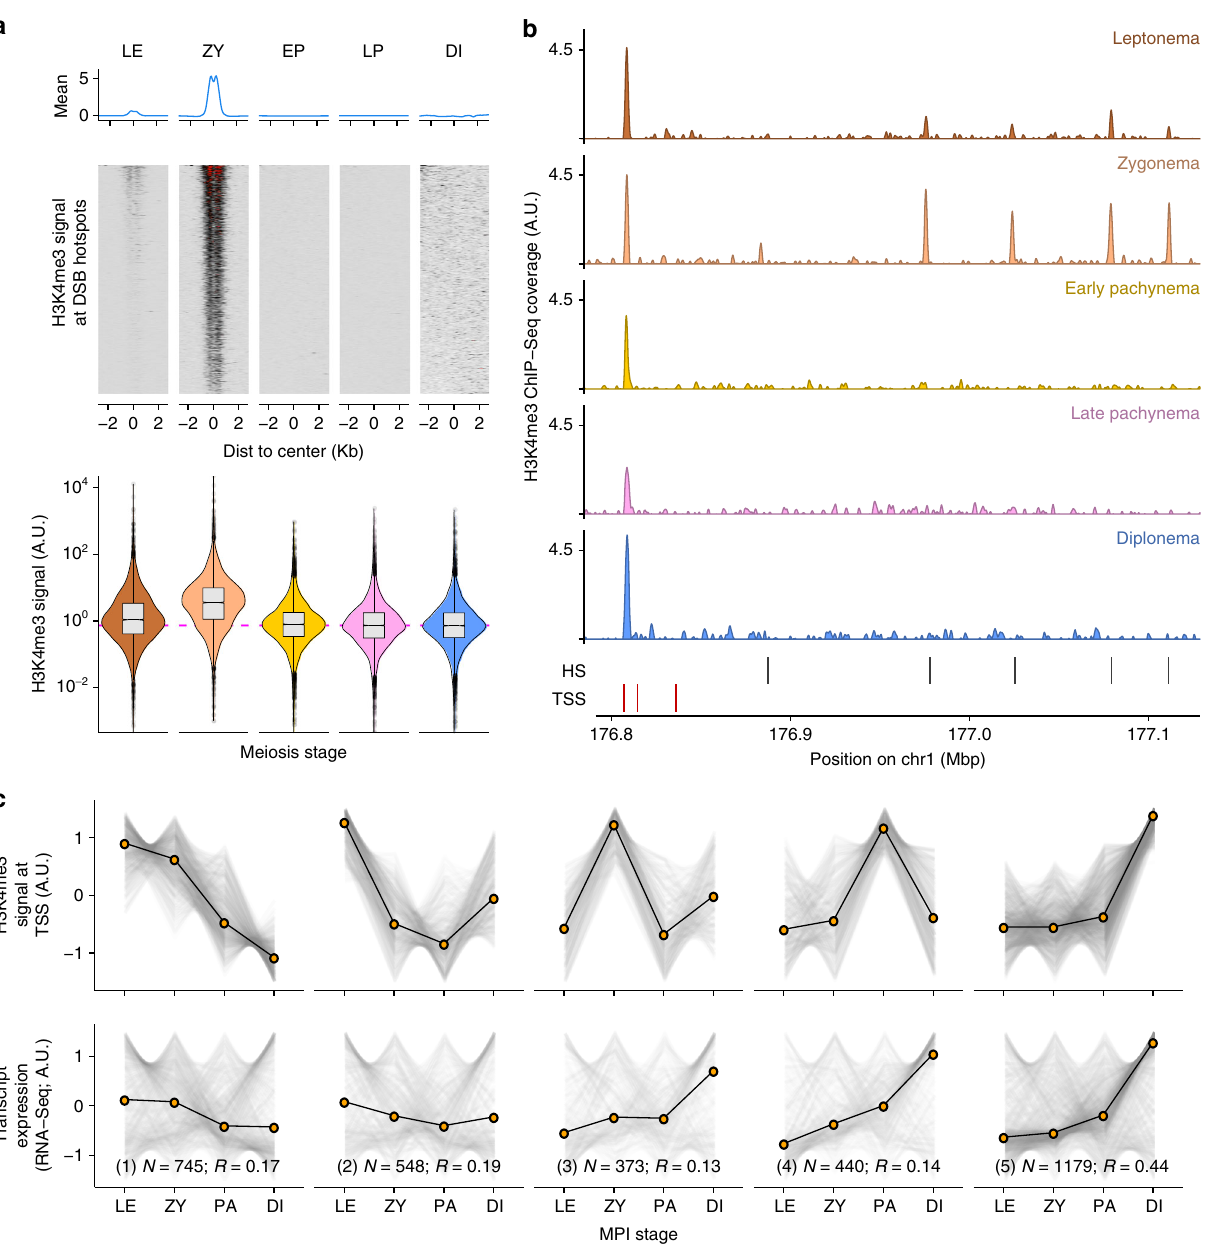
Fig. 3 H3K4me3 dynamics across meiotic substages. a H3K4me3 dynamics at DSB hotspots across fi ve meiotic substages. H3K4me3 signals at DSB hotspots are normalized by the spike-in H4K4me3 mononucleosomes. Quanti fi ed H3K4me3 signal is shown in violin plot (lower panel). b H3K4me3 dynamics at different genomic elements in fi ve sorted subpopulations of meiotic nuclei. HS hotspots, TSS transcription start sites. c Stage-speci fi c H3K4me3 at TSSs recapitulate meiotic gene expression patterns. Genes with only one isoform are selected for this analysis. H3K4me3 pro fi les at TSSs are grouped into fi ve clusters (top), while the respective mRNA levels are shown in the bottom panel. LE Leptonema, ZY Zygonema, PA Early and Late Pachynema, DI Diplonema. The number of transcripts per cluster (N) and Spearman correlation coef fi cient (R) for all transcripts are shown. Source data are provided as a Source Data fi